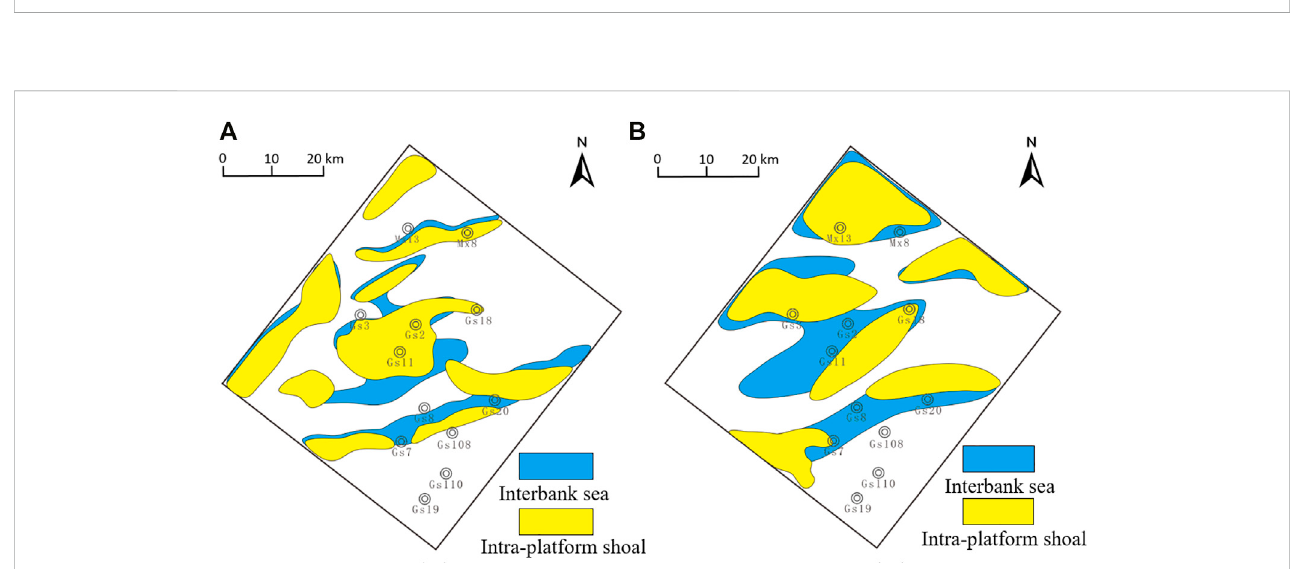
FIGURE 15 Evolution diagram of sedimentary microfacies in each fourth order sequence: (A) evolution diagram of the sedimentary microfacies in the SQ1 period (interbank sea microfacies in TST1 period gradually evolved into intraplatform shoal microfacies in the HST1 period); (B) evolution map of the interbank sea to intraplatform beach in the SQ2 period (interbank sea microfacies in the TST2 period gradually evolved into intraplatform beach microfacies in the HST2